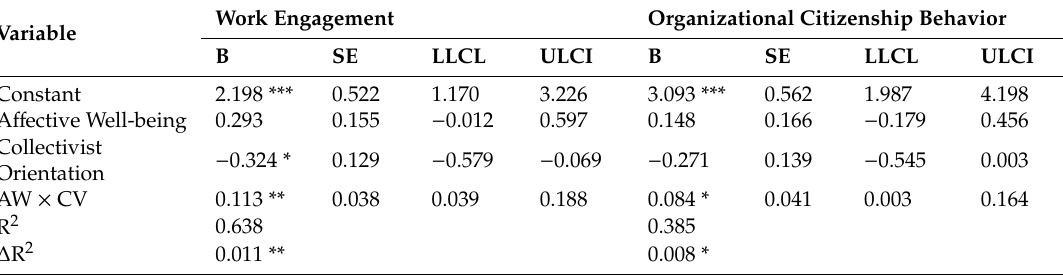
Table 5. Moderation e ff ects of collectivist